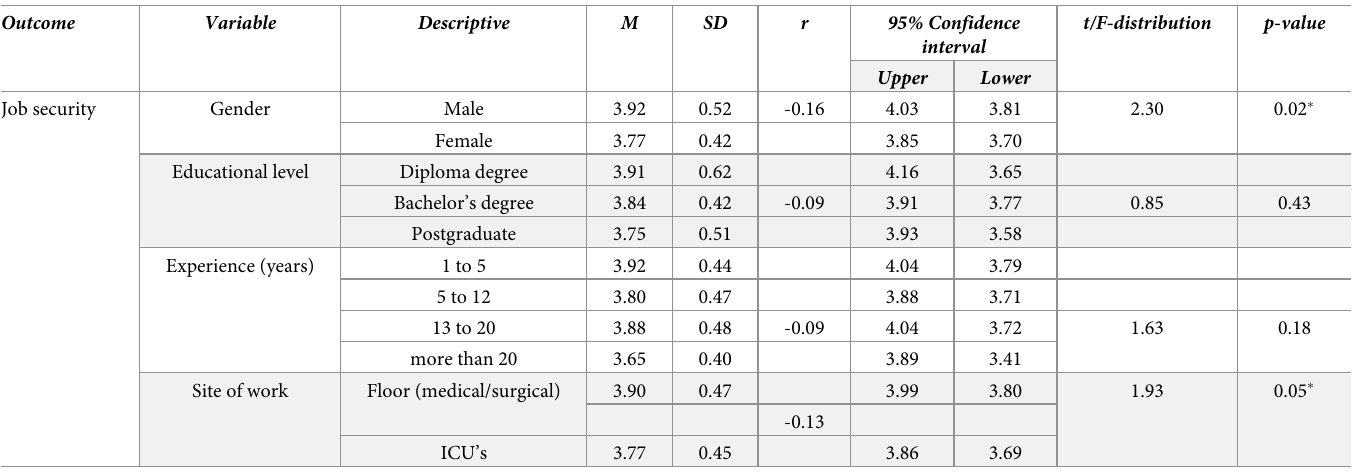
Table 4. Differences between demographic factors and job security among Jordan University Hospital nurses (N = 214). Outcome